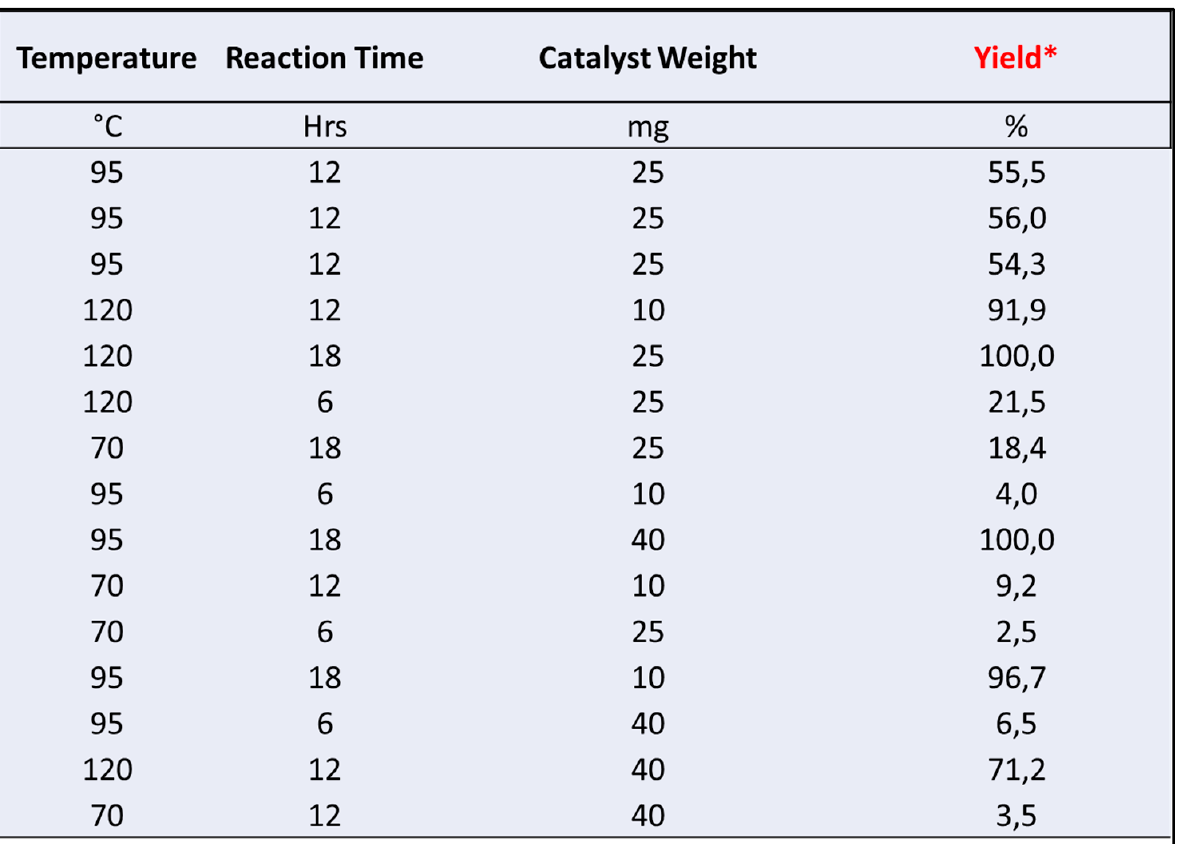
Figure 4. DOE experiments for evaluation of reaction parameters.